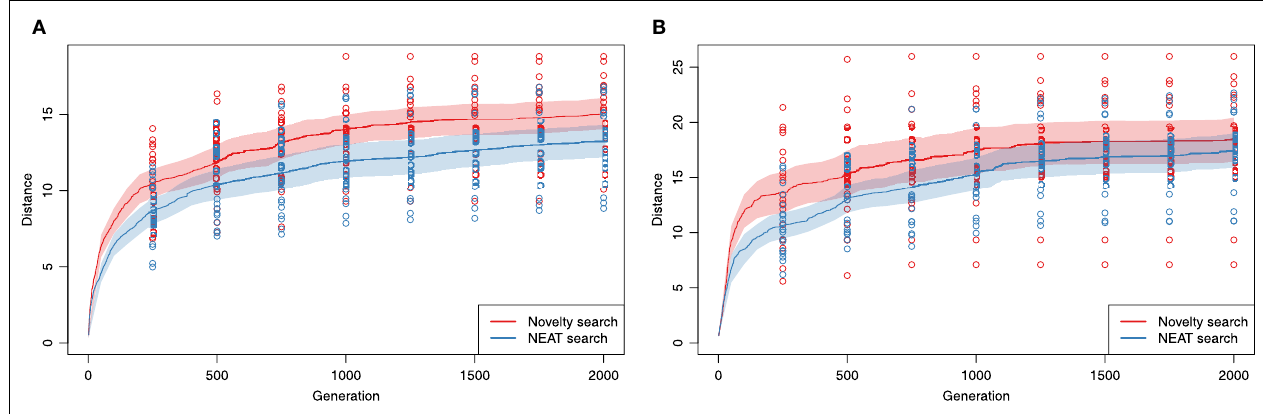
FIGURE 6 | Oscillator-driven actuation: performance of novelty search compared to the NEAT algorithm on the problem of co-evolving morphology and controller of soft-bodied, swimming (A) and walking (B) animats . Solid lines show mean best fitness in a given generation from 20 evolutionary runs of each type of experiment. Dashed lines show 95%, bootstrapped confidence intervals for the means. (A) Aquatic environment, (B) terrestrial environment.